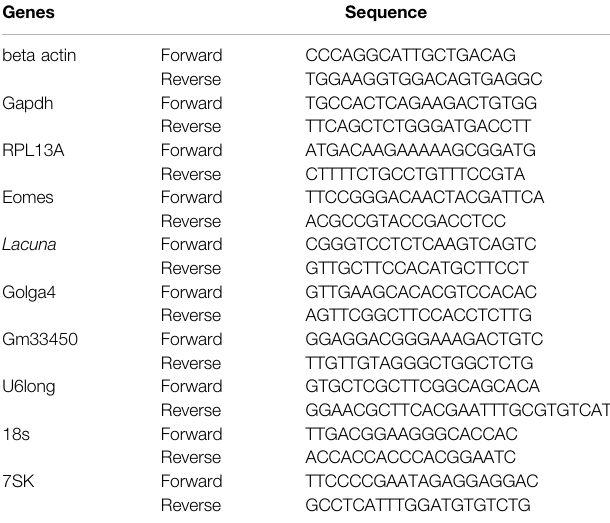
FIGURE 2 | differentiate to generate neurons and astrocytes. (B) Lacuna and Control transfected Neural Stem cells were treated with BrdU for 2 h and then fi xed and stained with anti-BrdU antibody (red), anti-GFP antibody (green) and 4, 6-diamidino-2-phenylindole (DAPI). Arrows indicate BrdU/GFP double positive cells. Scale bar: 250 μ m. (C) Quanti fi cation of BrdU incorporation in transgene positive mouse Neural Stem cells (GFP: 19.55 ± 3.104%, Lacuna : 13.06 ± 1.098%, p > 0.05, N (cid:2) 6independentexperiments,intotal596cellsforControlconditionand388cellsfor Lacuna condition). (D) Lacuna andControltransfectedmouseNeuralStem cells were immunostainedfor cleaved caspase 3(red),and GFP(green)and labeled with DAPI. Scale bar:250 μ m. (E) Quanti fi cation ofcleaved caspase 3positive cellsintransgenepositivemouseNeuralStemcells(GFP:5.629 ± 1.409%, Lacuna :10.05 ± 2.144%, p > 0.05, N (cid:2) 4independentexperiments,intotal374cellsfor Control condition and 521 cells for Lacuna condition). (F) Lacuna and Control transfected mouse Neural Stem cells were immunostained for Nestin (red), GFP (green) and labeled with DAPI. Arrows indicate Nestin/GFP doublepositive cells. Scale bar: 100 μ m. (G) Quanti fi cation of Nestin positive cells in transgenepositive mouse Neural Stem cells (GFP: 28.59 ± 2.323%, Lacuna : 43.55 ± 3,378%, p < 0.05, N (cid:2) 4 independent experiments, in total 363 cells for Control condition and 410 cells for Lacuna condition). For all cases, * p < 0.05, ** p < 0.01, *** p <